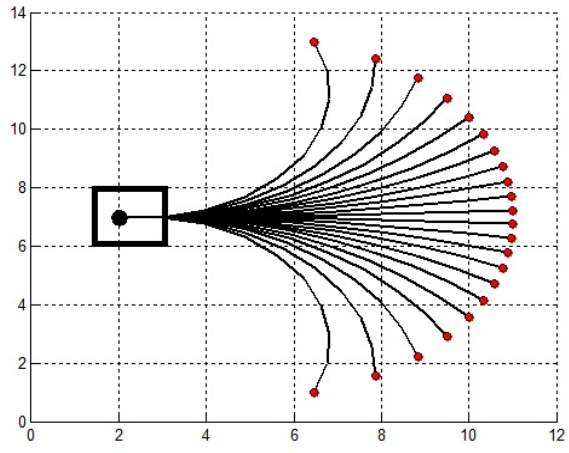
Figure 4. Schematic diagram of vehicle feasible path.